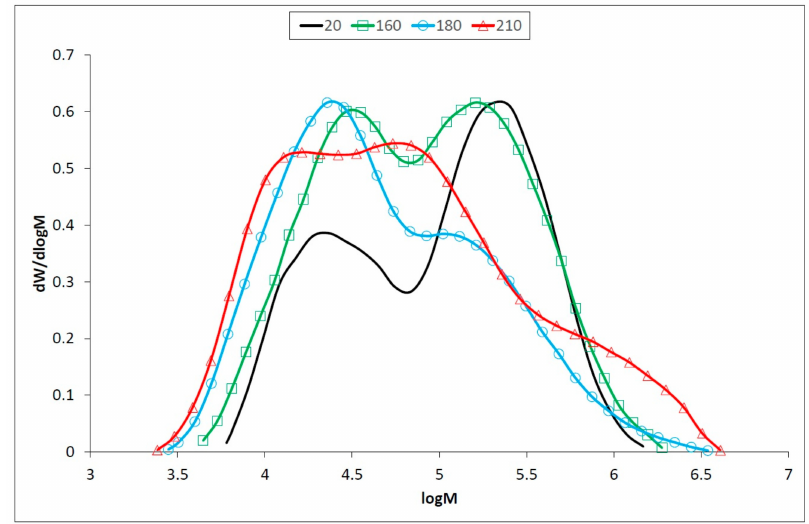
Figure 5. Molecular weight distribution of oak wood holocellulose before and after thermal